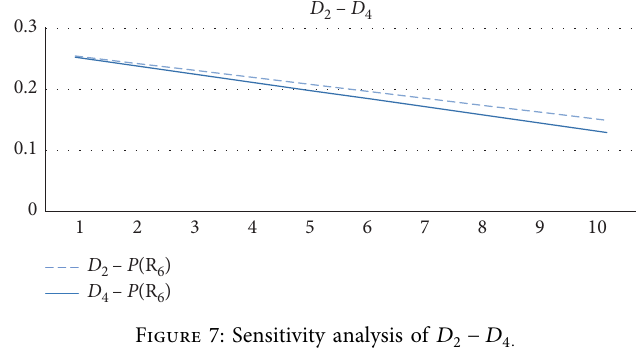
Figure 7: Sensitivity analysis of D